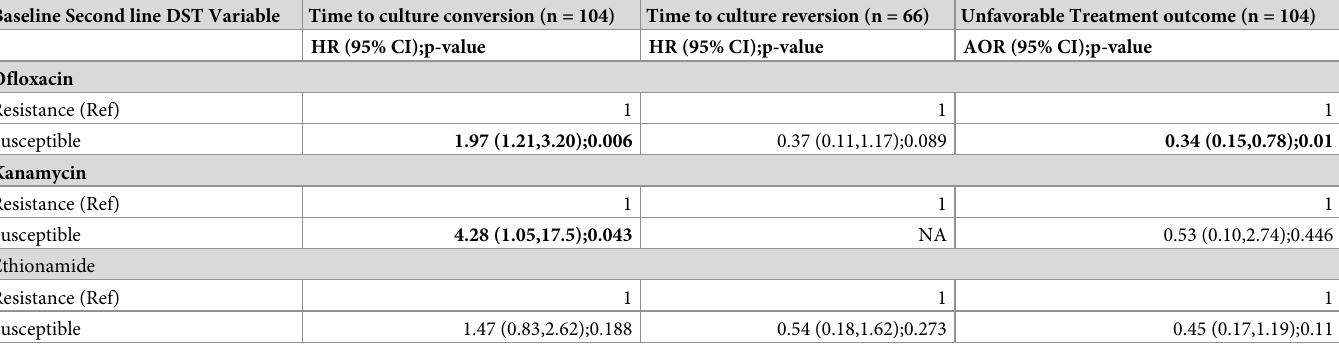
Table 7. Baseline second line DST results as factors significantly associated with time to culture conversion, time to culture reversion and unfavorable treatment outcomes using survival and logistic regression analysis. (Note: HR > 1 indicates higher chances of culture conversion, higher hazard of reversion after conversion and higher hazard of unfavorable treatment outcome in the respective